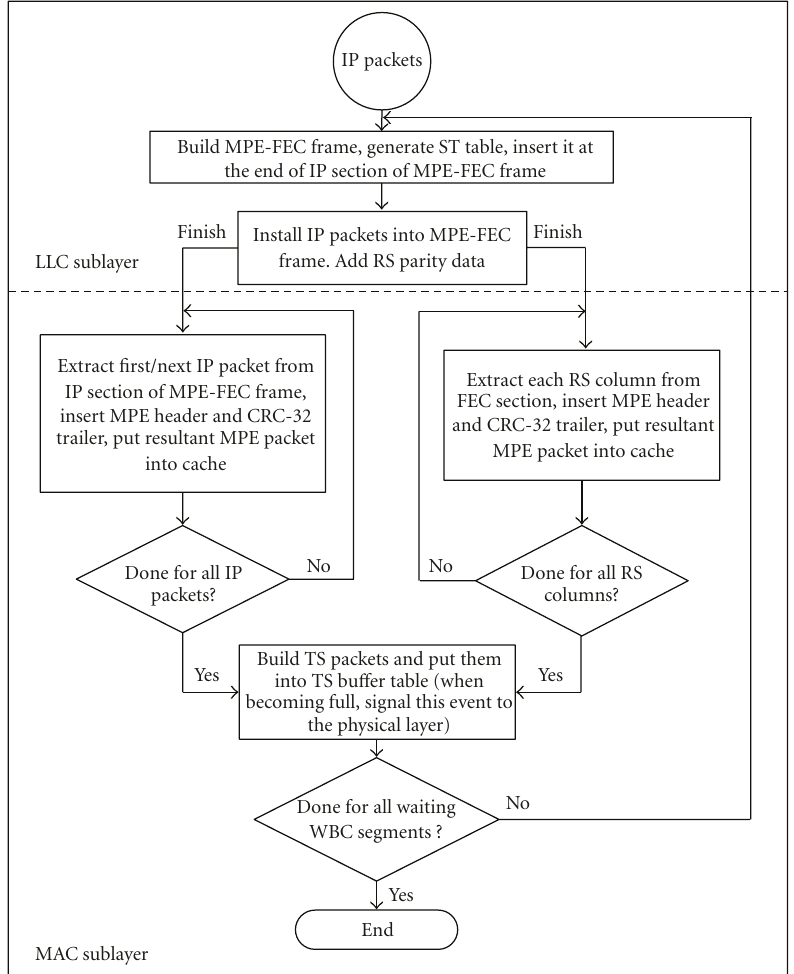
Figure 10: The “WBC over DVB-H” link layer encoder’s functional